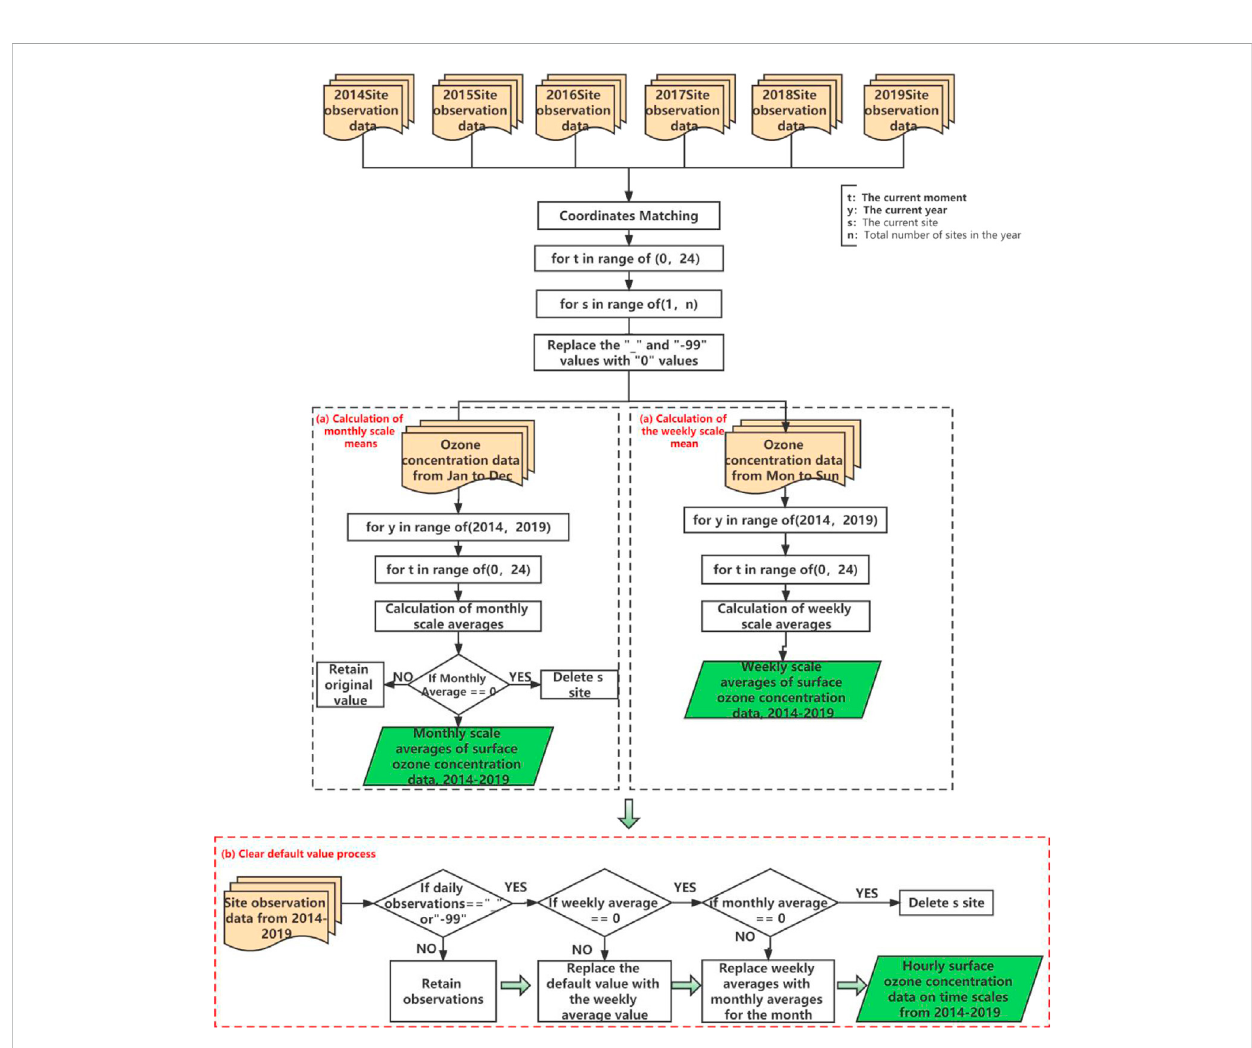
FIGURE 2 Process of surface observation O 3 concentration data cleaning